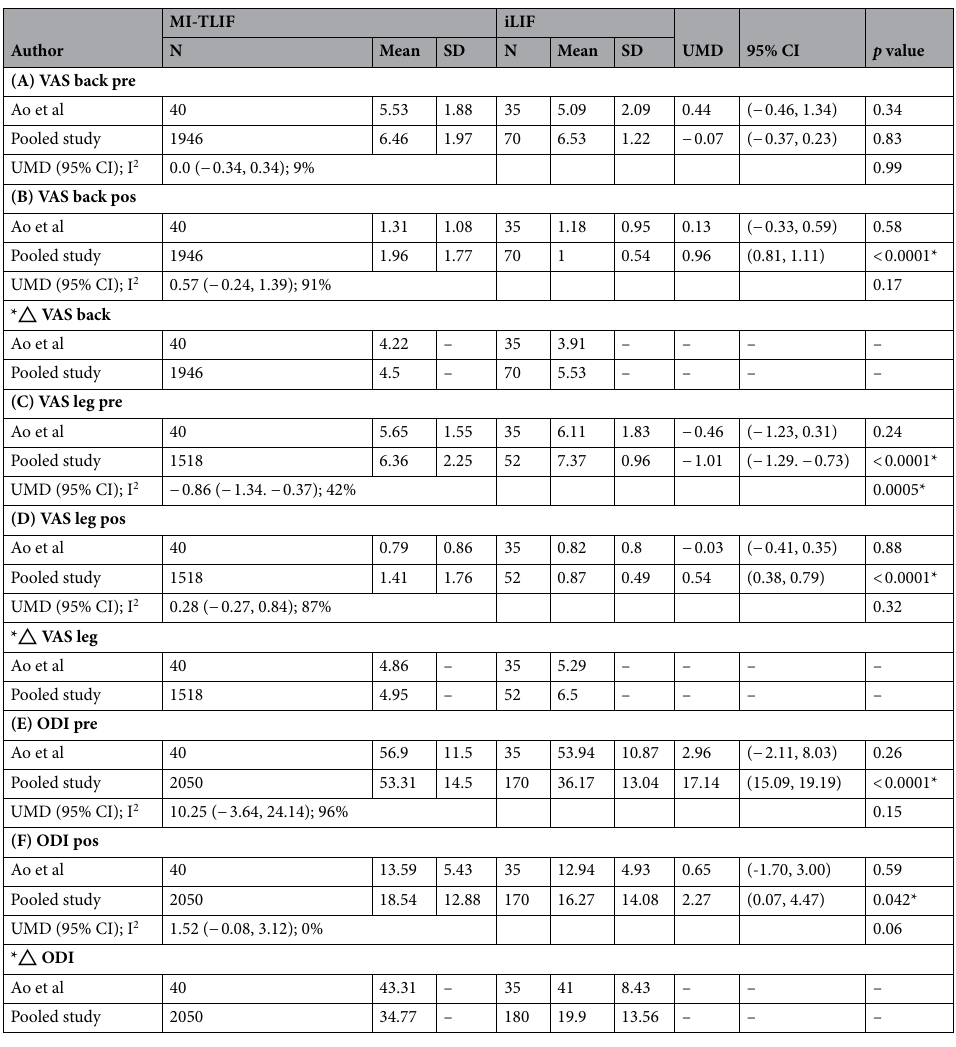
Table 7. Unstandardized mean differences and baseline to last follow-up mean differences of VAS back, leg and ODI between MI-TLIF and iLIF. * △ Baseline to last follow-up mean variation.